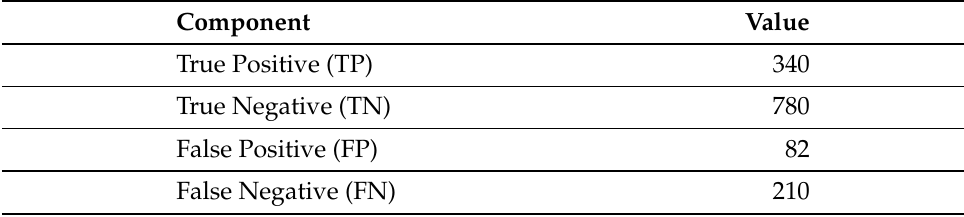
Table 1. Confusion matrix for the validation data.